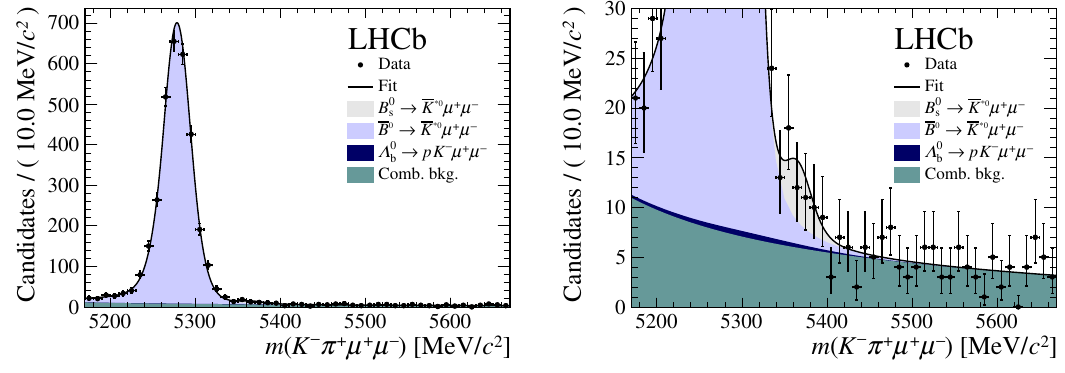
Figure 1 . Distribution of reconstructed K (cid:0) (cid:25) + (cid:22) + (cid:22) (cid:0) invariant mass of candidates outside the J= and (2 S ) mass regions, summing the three highest neural network response bins of each run condition. The candidates are shown (left) over the full range and (right) over a restricted vertical range to emphasise the B 0 ! K (cid:3) 0 (cid:22) + (cid:22) (cid:0) component. The solid line indicates a combination of the s results of the (cid:12)ts to the individual bins. Components are detailed in the legend, where they are shown in the same order as they are stacked in the (cid:12)gure. The background from misidenti(cid:12)ed B 0 ! K (cid:3) 0 (cid:22) + (cid:22) (cid:0) decays is included in the B 0 ! K (cid:3) 0 (cid:22) + (cid:22) (cid:0)